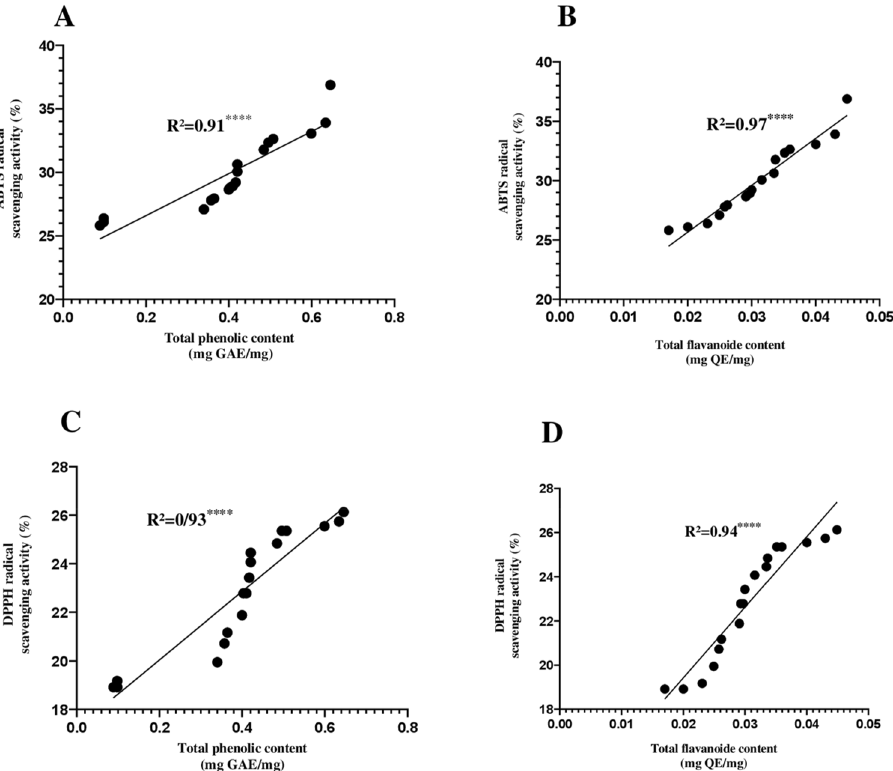
Figure 11. Pearson correlation graphics. ( A ) Pearson correlation between ABTS and total phenolic content, ( B ) Pearson correlation between ABTS and flavonoids content, ( C ) Pearson correlation between DPPH and total phenolic content, and ( D ) Pearson correlation between DPPH and flavonoids content. “****” ( P < 0.0001) highly significant between